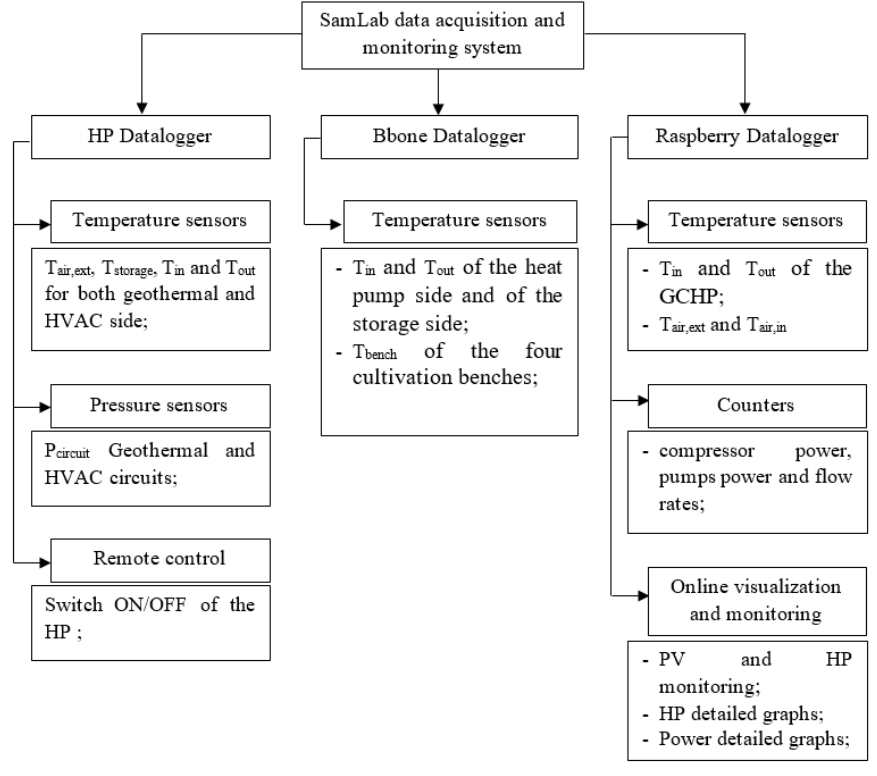
Figure 2. SamLab greenhouse data acquisition and monitoring subsystems.